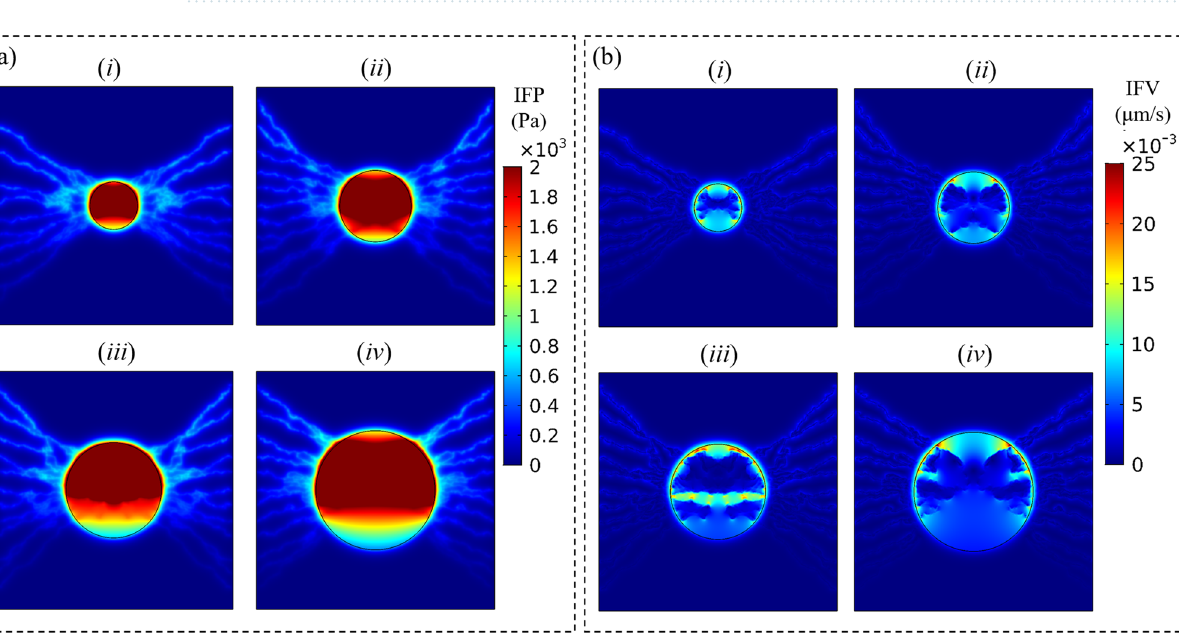
Figure 4. Intravascular pressure distribution and %MVD at different stages of vascularized tumor progression. MVD is increased as the tumor diameter increases (white and gray color regions indicate tumor and healthy tissues, respectively).